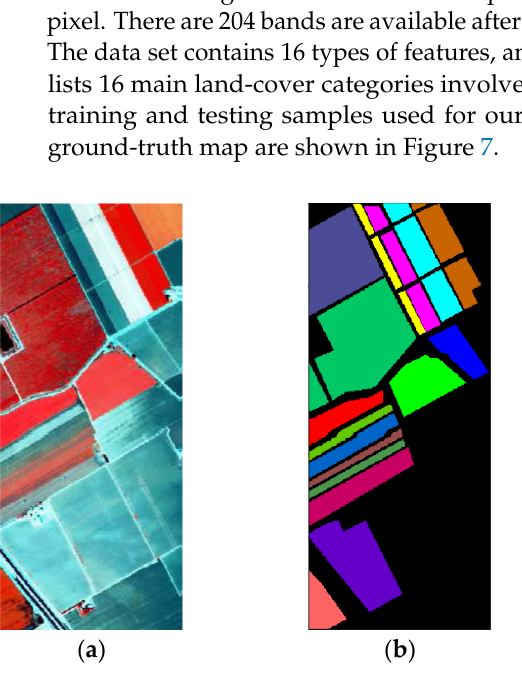
Table 4. Number of training and test sets for the Salinas data set.